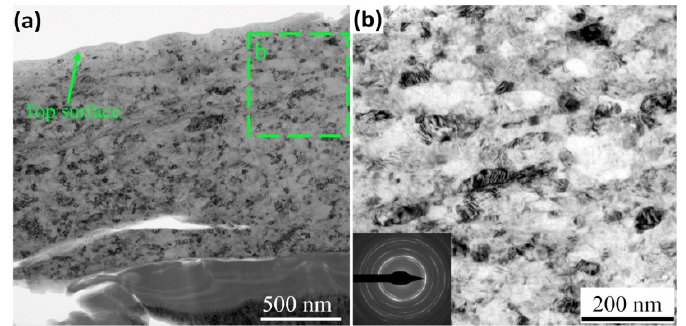
Figure 5. TEM micrograph presenting ( a ) nanostructures on the surface of UNSM-treated Ti6Al4V, ( b ) magnified view of location b. Reprinted with permission from ref. [92] . Copyright 2019, Elsevier.